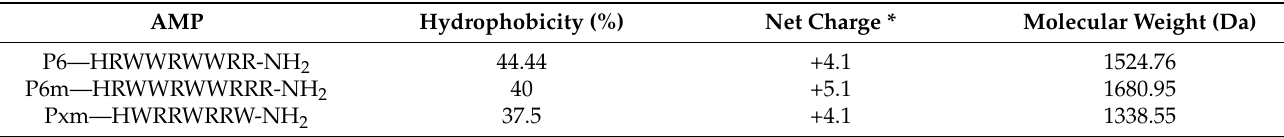
Figure 1. Representation of the major types of molecular systems analyzed in this paper: ( a ) cross-section of OmpF inserted in the S-LPS E. coli (Lipid A, K12 core, 1 O21 O-antigen) membrane model and ( c ) cross-section of OmpF inserted in the R-LPS E. coli (LipidA, R1 core) membrane model; ( b ) sequence of S-LPS and ( d ) sequence of R-LPS used to build the two distinct E. coli membrane models. Lipid A is colored in mauve; shared residues between the two LPS types are colored in green; the unique saccharide residues of the two core types are colored in red and violet; O-antigen is colored in blue; while PL from the bottom leaflet are colored in gray. Table 1. Physical and chemical properties of AMPs.